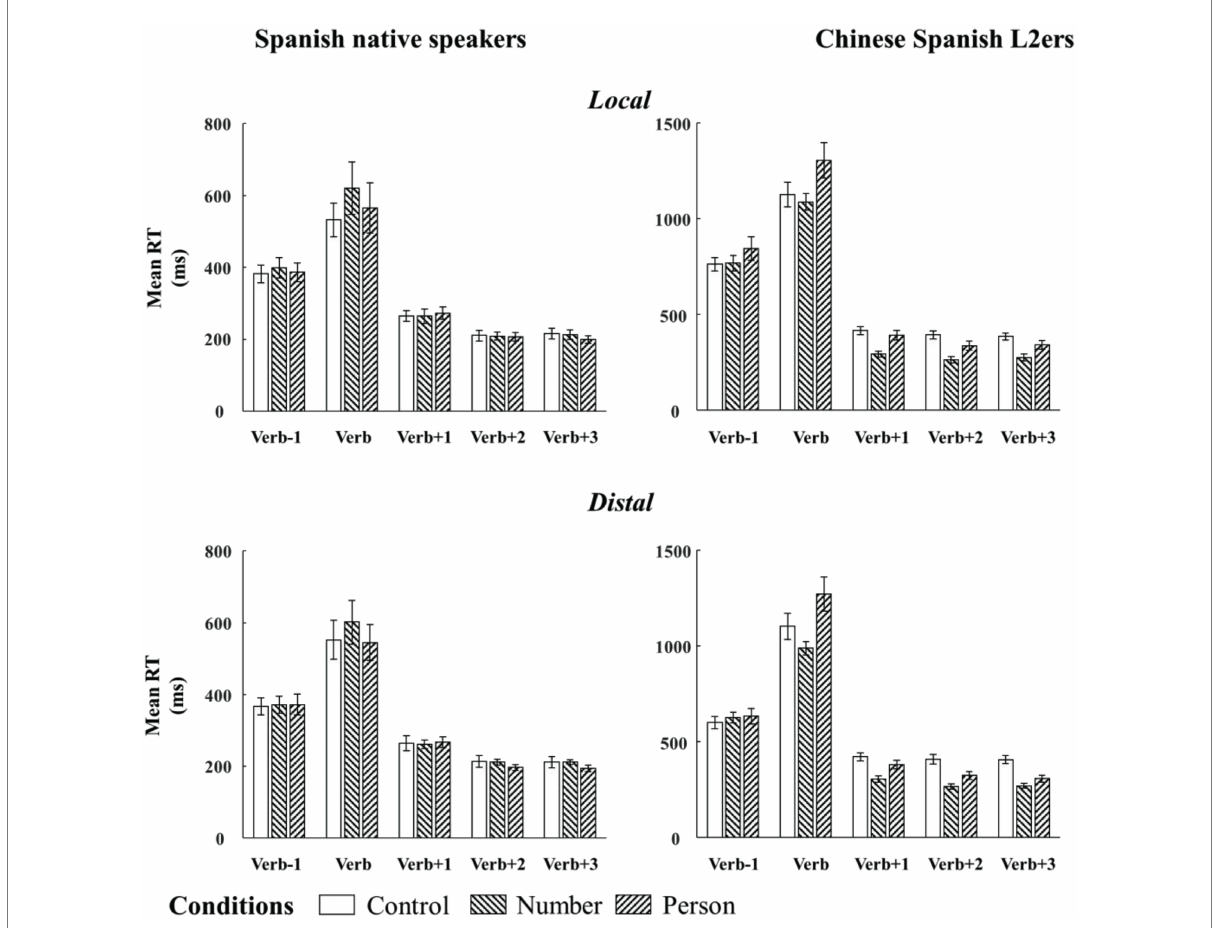
FIGURE 4 Bar plots of mean RTs (and by-subject standard errors) to SV agreement in the two configurations from native Spanish speakers and Chinese Spanish L2ers. Mean RTs were divided into five regions: the target verb, one preceding word, and three following words.